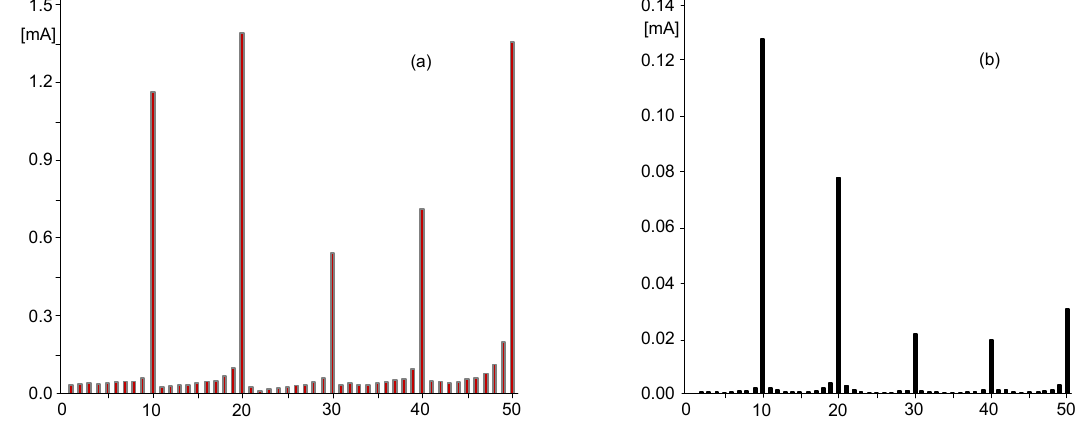
current spectrum without filter; ( b ) The C 1